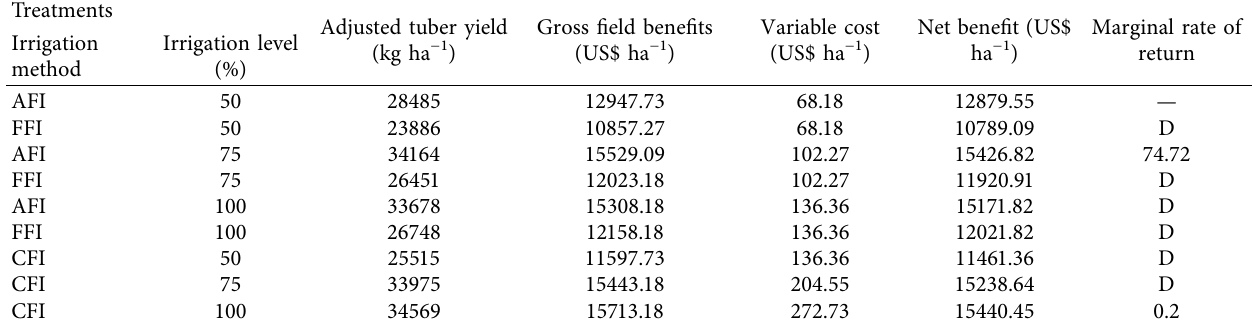
Table 5: Economic analysis based on mean values for potato production for the use of different irrigation methods and levels of irrigation water on potato